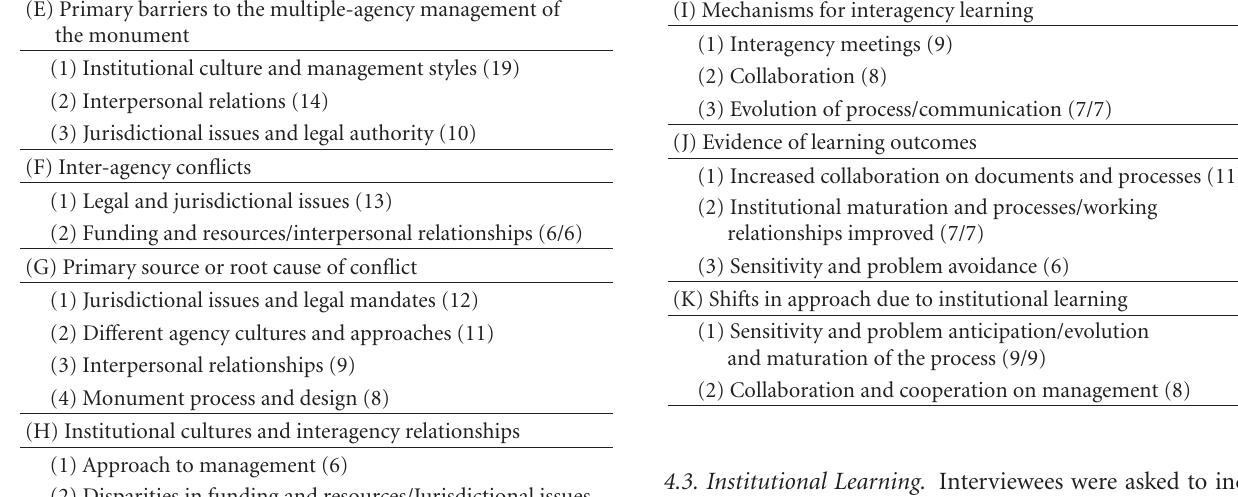
Table 5: Institutional learning: interviewee responses by conceptual category (i)–(k). Numbers in parentheses indicate number of responses from a total pool of 23